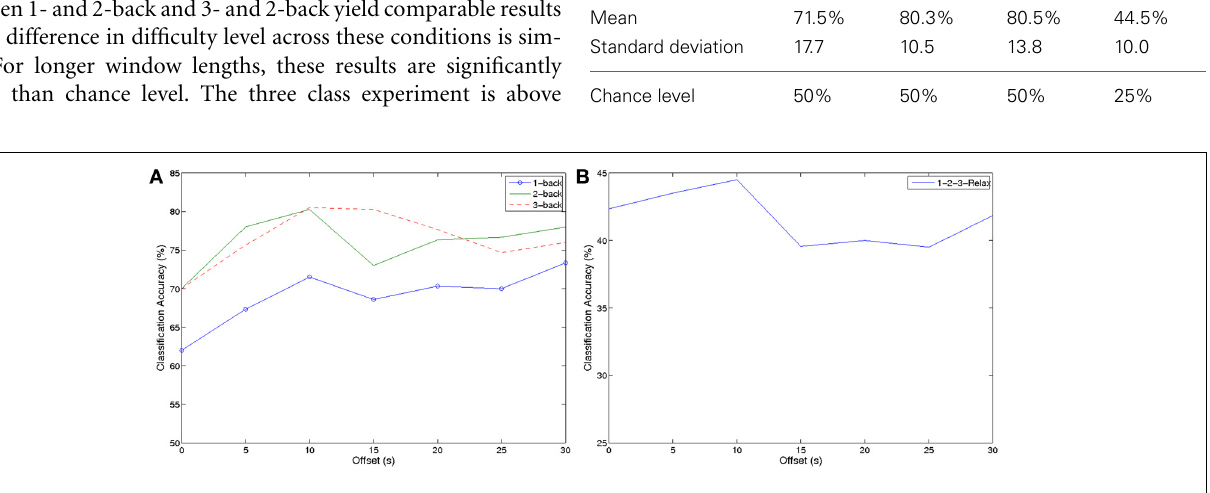
FIGURE 5 | Classification accuracies for n -back tasks depending on the offset from trial start (A) two class problems of classification accuracy of 1-,2-,3-back against Relax (B) four class classification between all three n -back and R ELAX .